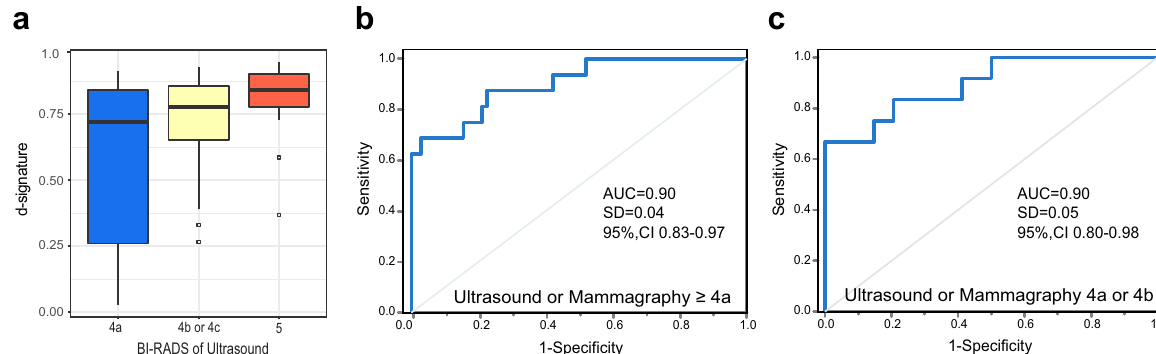
Fig. 5 Combined imaging results with exLR-based d-signature for BC diagnosis. a ExLR d-signature scores in BC patients with different BI-RADS scores. b , c ROC for the performance of exLR d-signatures in BC with ultrasound or mammography ≥ 4a ( b ) and 4a or 4b ( c